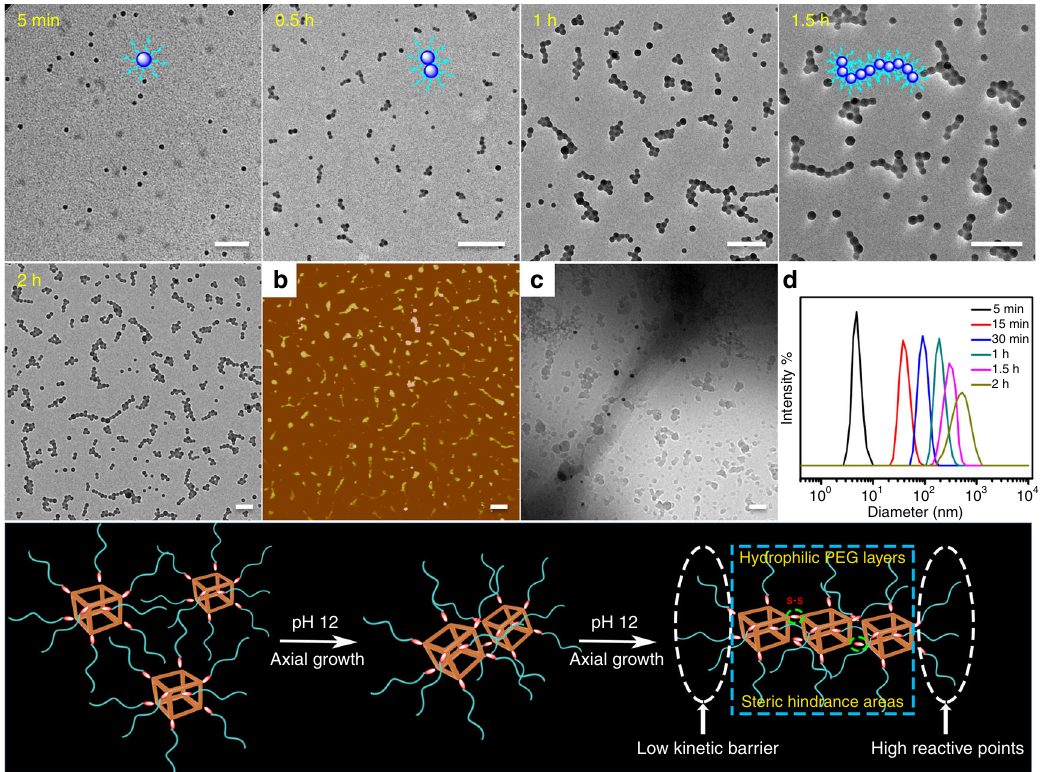
Fig. 3 Mechanism of the hierarchically axial growth of the micelles. After neutralizing the aqueous solution and removing the by-products before dialysis, all the samples are prepared from the neutralized aqueous solution unless otherwise noted. a TEM images showing the self-assembled evolution of POSS-SS-(PEG) 8 with the concentration of 1 mg/mL in pH 8 solutions for various times. Insets are the correspondingly schematic structures. b AFM and c Cryo-TEM images of the short cylindrical formations at 2 h. Scale bars: 50 nm. d DLS results of the nanoparticles for various times. e The possible self-assembled mechanism of nanostructural axial growth. In this process, the thiol – disul fi de exchange reaction makes the disperse unimolecules quickly aggregate and interlink by the disul fi des, thus forming many oligomer-linked cylinders from the pre-micelles with the hierarchical self-assembly behaviors. The low kinetic barrier at both ends, due to the steric hindrance areas from POSS-embedded domains and the swollen layers from stretched PEG shells, furnishes these cylinders with higher reactive points at the micellar ends and drives the subunits to connect together. The orange cube represents the POSS core, the red ellipsoid represents the disul fi de linkage and the cyan chain represents the PEG